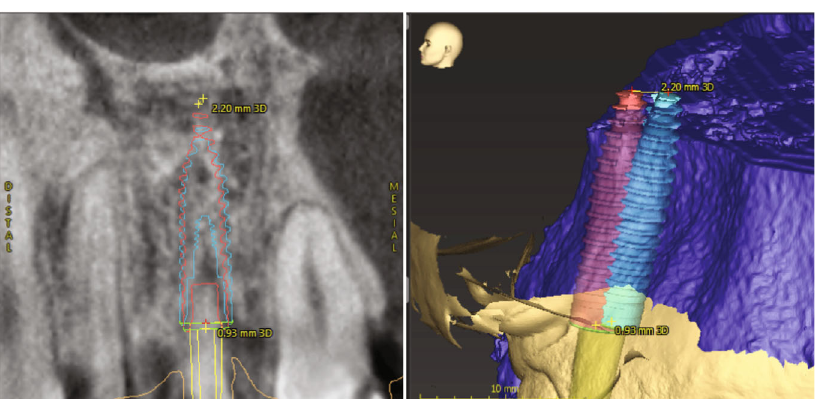
Figure 9: Deviations observed in superimposed images of the placed and planned implant position in the tangential and axial views, respectively.